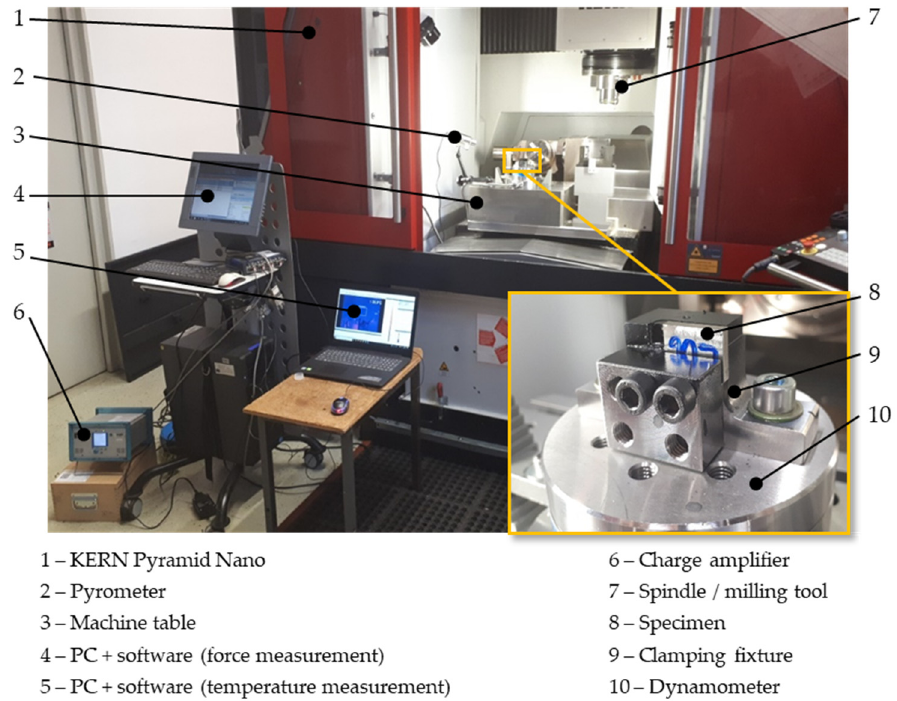
Figure 9. Experimental set-up including measurement technology for the milling tests.